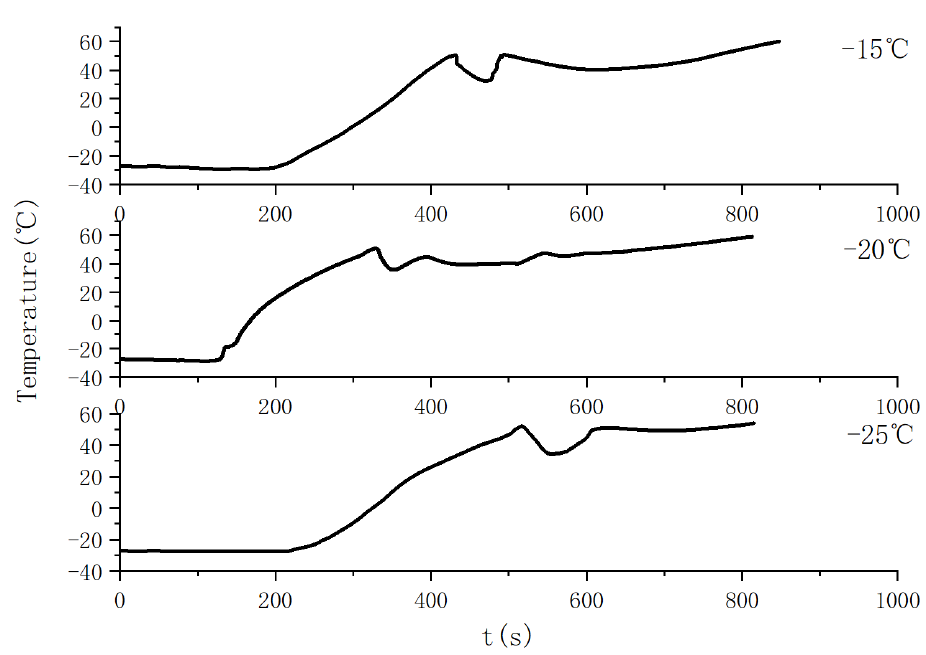
Figure 2. Graph of the temperature change in Stack A with time.